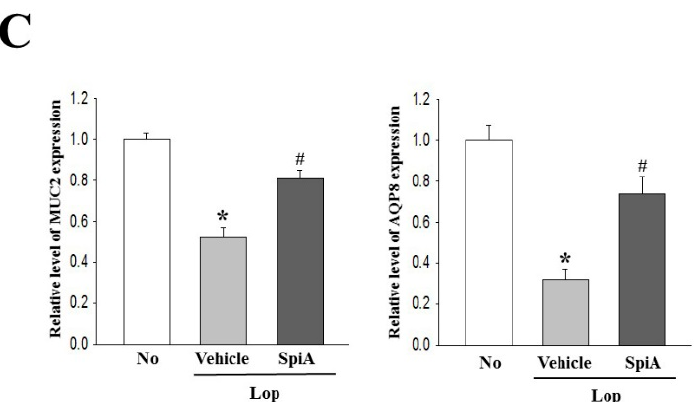
Figure 3. Mucin secretion and membrane water channel expression in the colon. ( A ) Mucin secreted from crypt layer cells was stained with Alcian blue at pH 2.5, and images were observed at 400× magnification. Five-to-six mice per group were used in preparation of Alcian blue stained colon tissue. ( B ) The levels of MUC2 and AQP8 transcripts in the total mRNA of colons were measured by semiquantitative RT-PCR using specific primers. After the intensity of each band was determined using an imaging densitometer, the relative levels of MUC2 and AQP8 mRNA were calculated based on the intensity of actin as an endogenous control. Five to six mice per group were used in preparation of total RNA and specific transcript level was assayed in duplicate in each test. ( C ) Quantitative real-time PCR analyses were performed to evaluate the levels of MUC2 and AQP8 transcripts in the similar way described as described in Figure 3B. Data are reported as the mean ± SD. *, p < 0.05 compared to the untreated group. # , p < 0.05 compared to the Lop + Vehicle treated group. No, Untreated group; Lop, Loperamide; SpiA, Spicatoside A, RT-PCR; Reverse transcription-polymerase chain reaction, MUC2; mucin 2, AQP8; aquaporin